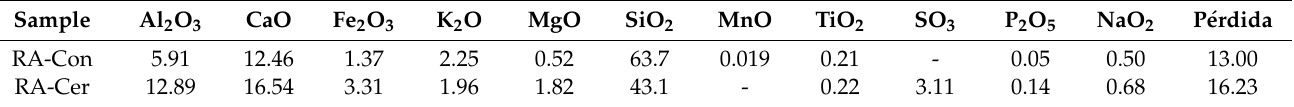
Table 3. Percentage values of the different compounds found in the X-ray fluorescence analysis.